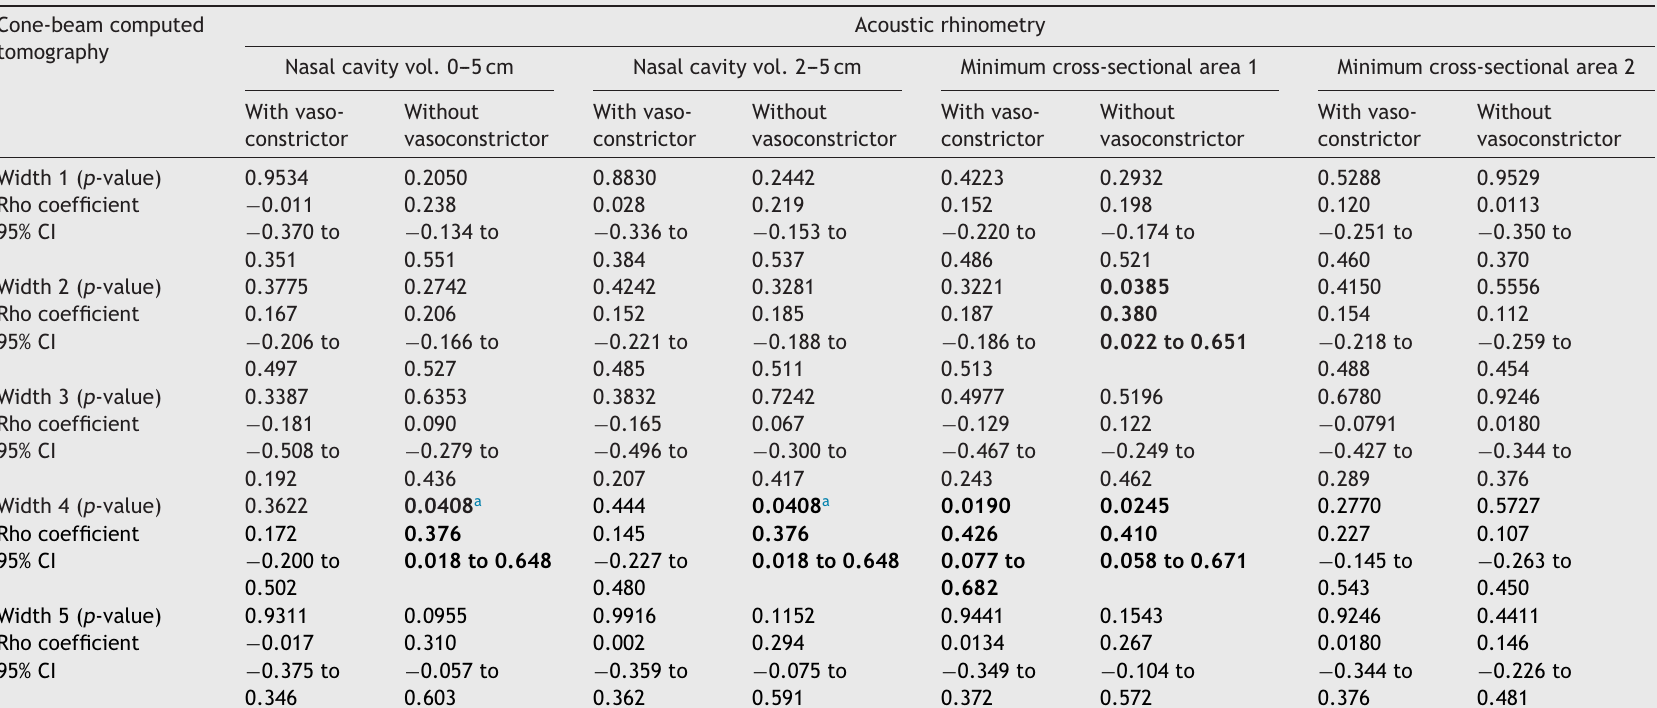
Correlation between data of cone-beam computed tomography and acoustic rhinometry in mouth breathers with transverse maxillary deficiency. Cone-beam